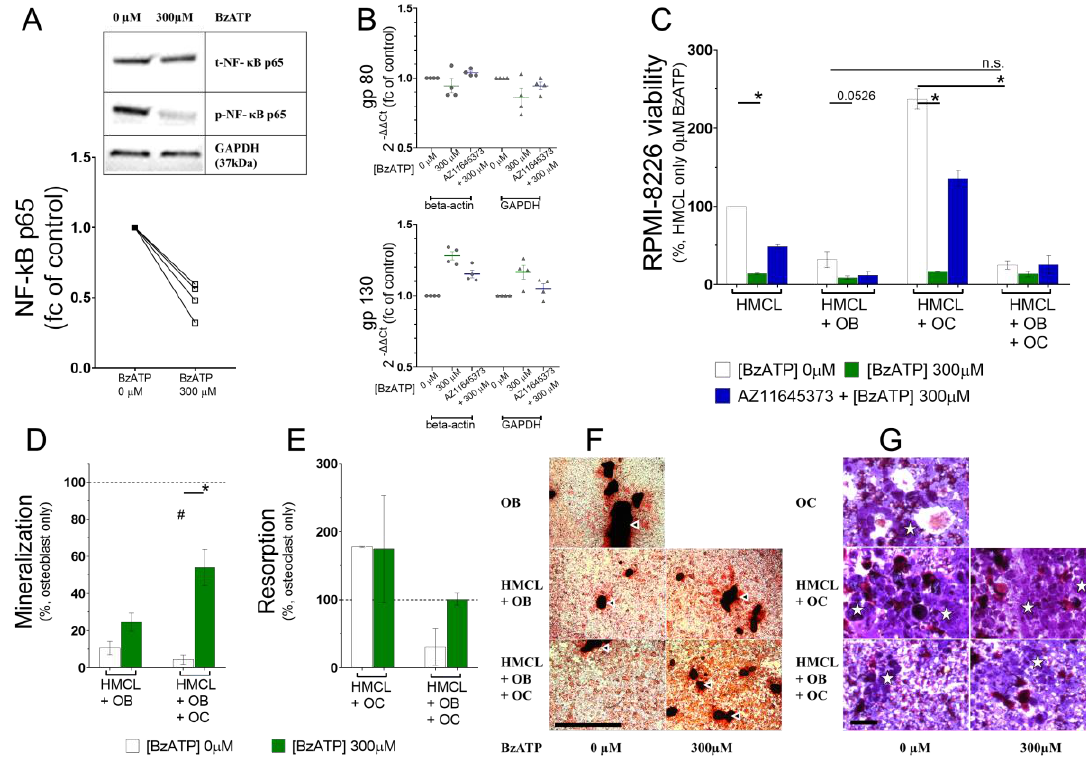
Figure 4. P2X7 receptor activation of transcription regulators and subsequent alterations in RPMI-8226–osteoblast and RPMI-8226–osteoclast interaction. ( A ) Western blot to show the nuclear factor- κ appa B (NF- κ B) phosphorylation using phosphorylation of NF- κ B (p-NF- κ B; p65) antibody and quantification of phosphorylated protein normalized to the total protein t-NF-kB (p65) after 90 min treatment with 300 µ M BzATP. GAPDH was probed as a protein loading control. ( B ) TaqMan qPCR analysis showing the expression of gp80 and gp130 after 90 min treatment with BzATP (300 µ M) alone, or after a 30-min pre-treatment with the antagonist (AZ11645373 + 300 µ M), as indicated. Data shows change in mean ± SEM of four independent experiments ( n ) as a fold change of untreated control (0 µ M); beta-actin and GAPDH were used as housekeeping genes. ( C ) E ff ects of RPMI-8266 treatment with 300 µ M BzATP for 90 min before culturing with bone cells for 48 h in an in vitro co-culture assay. The e ff ect on viability of RPMI-8266 (HMCL) in the presence of osteoblasts (HMCL + OB), osteoclasts (HMCL + OC), or both osteoblasts and osteoclasts (HMCL + OB + OC) ( D ), and on mineralization and resorption ( E ). Data shows mean ± SEM of independent experiments and * = p < 0.05 by Mann–Whitney test comparing the e ff ect of BzATP treatment or by Kruskal–Wallis comparison to compare the e ff ect of bone cells, or # = p < 0.05 by Mann–Whitney comparison to baseline bone cell function (dotted line) as indicated ( n = 3, RPMI-8266 viability; n = 4, mineralization; and n = 2, resorption). Representative images to show ( F ) Alizarin Red-stained mineralized nodules (white arrows heads) as a measure of osteoblast function (scale bar: 500 µ m) and ( G ) resorption (white stars) on dentine discs as a measure of osteoclast function (scale bar: 100 µ m; in